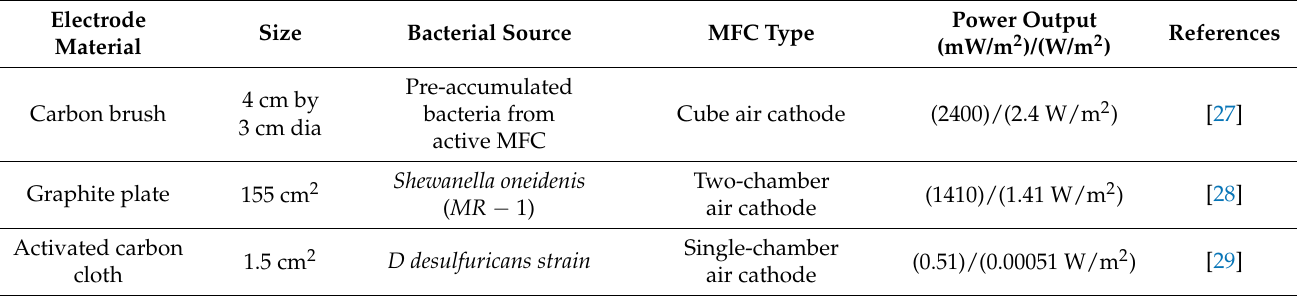
Table 1. Previous studies and literature where other carbon materials have been